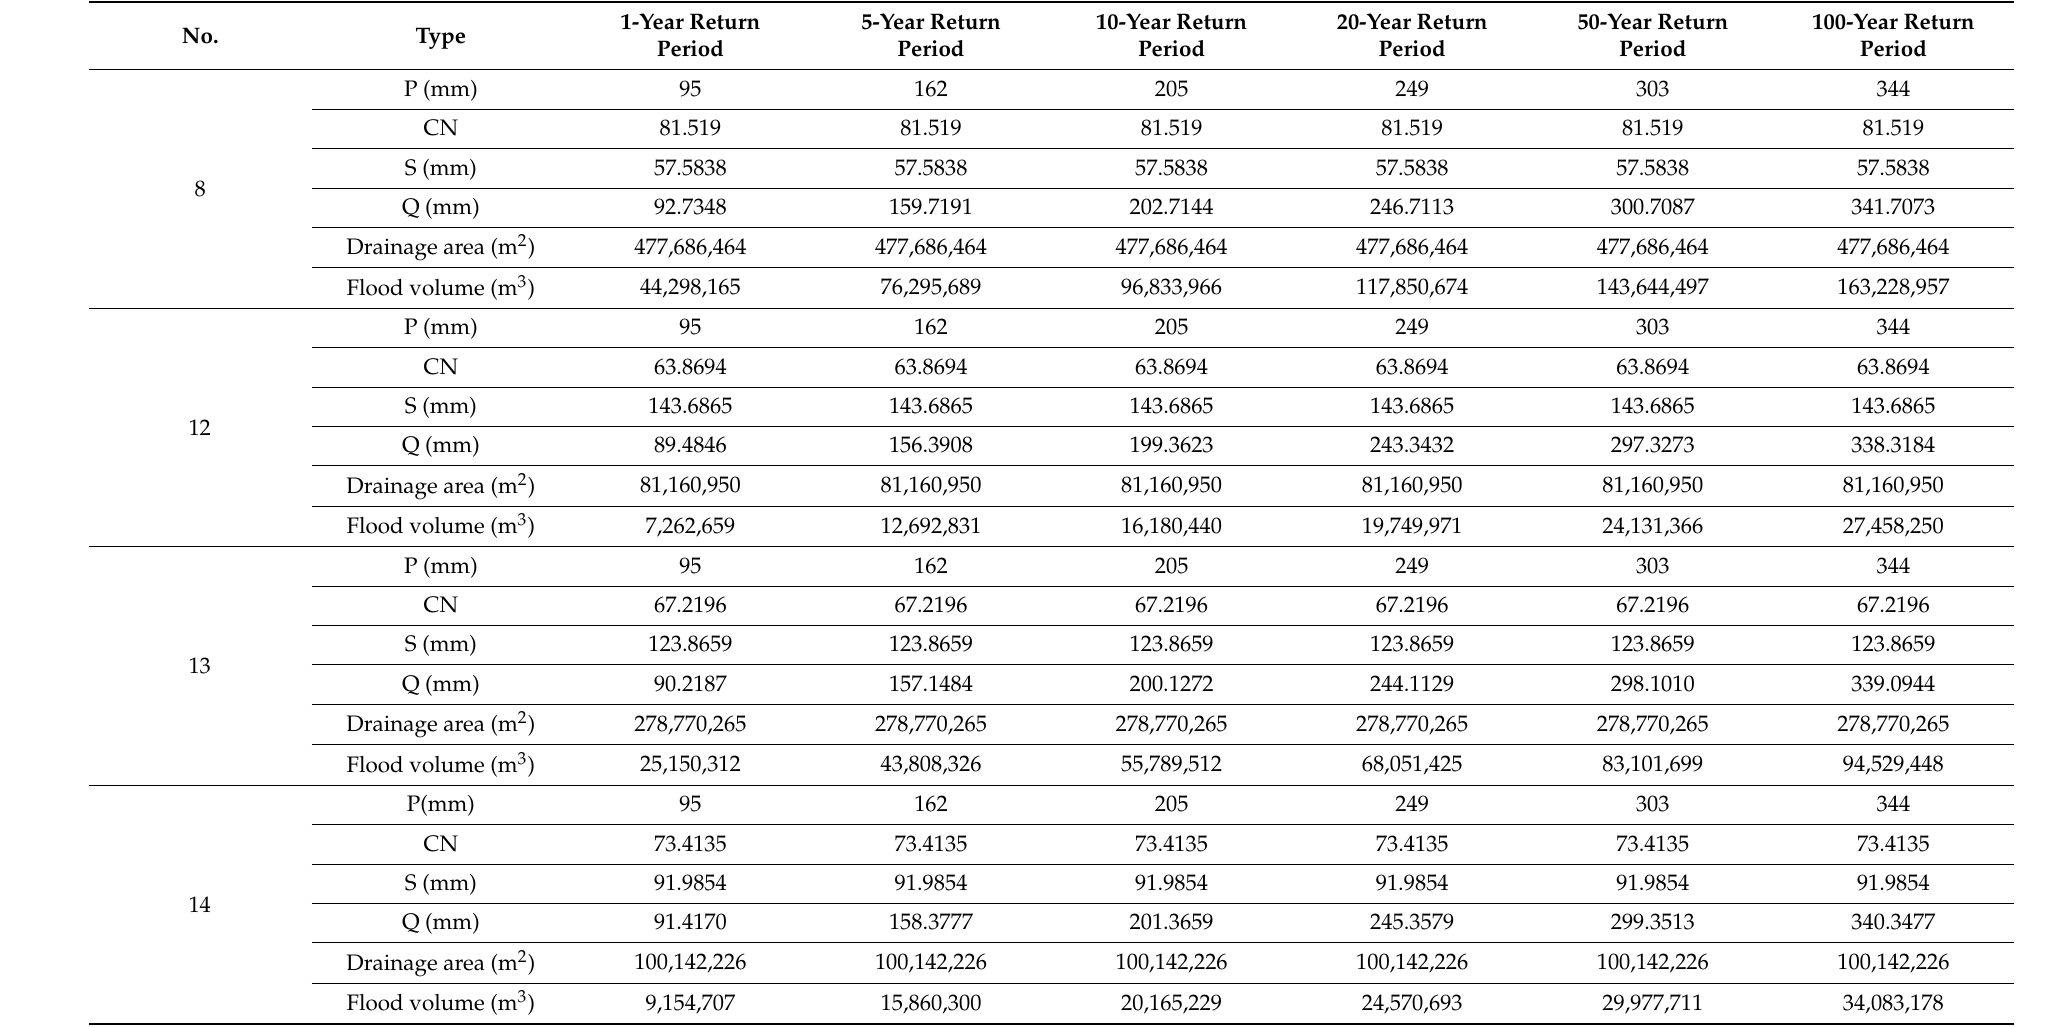
Table A3. List of results of SCS-CN